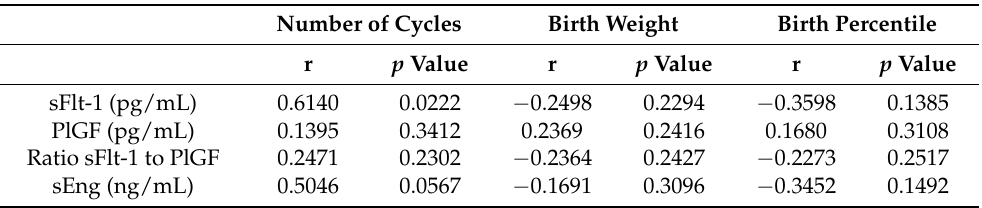
Table 3. Correlations between the number of cycles of chemotherapy administered, birth weight or percentile and angiogenic factors values at delivery.